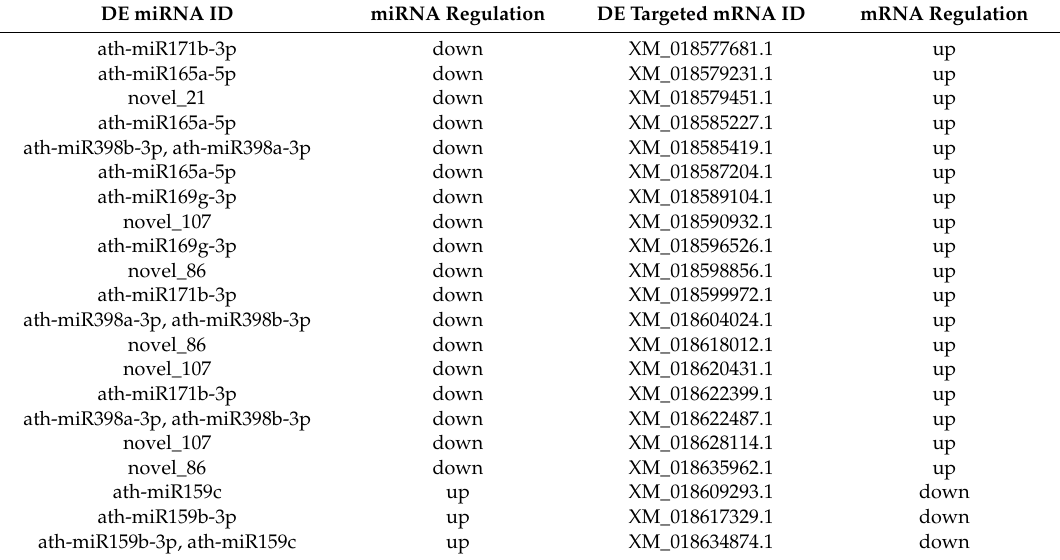
Table 3. The detailed information of DE circRNAs.